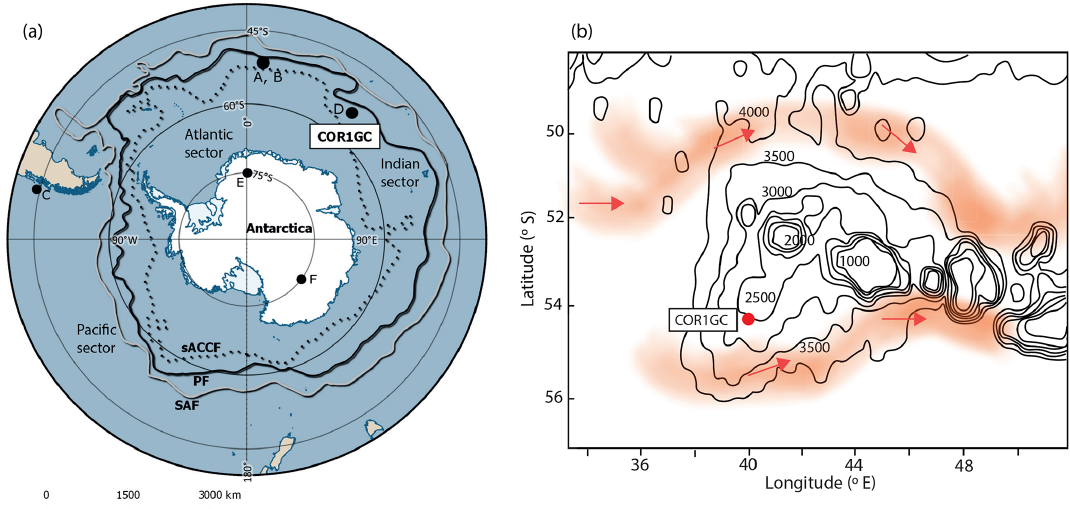
Figure 1. Location of core COR1GC in the western Indian sector of the Southern Ocean. (a) Map of the Southern Ocean and Antarctica. Key terrestrial ice and marine sediment cores mentioned in the text and in Fig. 7 are labelled: A: TN057-13-PC4 (Anderson et al., 2009; Divine et al., 2010); B: TN057-17-PC1 (Nielsen et al., 2004); C: MD07-3088 (Siani et al., 2013); D: COR1GC (this study); E: EDML (EPICA Community Members, 2006);F: Epica Dome C (EDC) (Jouzel et al., 2007). The mean location of the southern Antarctic Circumpolar Current Front (sACCF; dotted line), the polar front (PF; black line) and the Subantarctic Front (SAF; grey line) according to Orsi et al. (1995) are shown. (b) Bathymetric map of the Conrad Rise adapted from Ansorge et al. (2008) including areas of high absolute geostrophic velocity in red shading and direction of flow shown by red